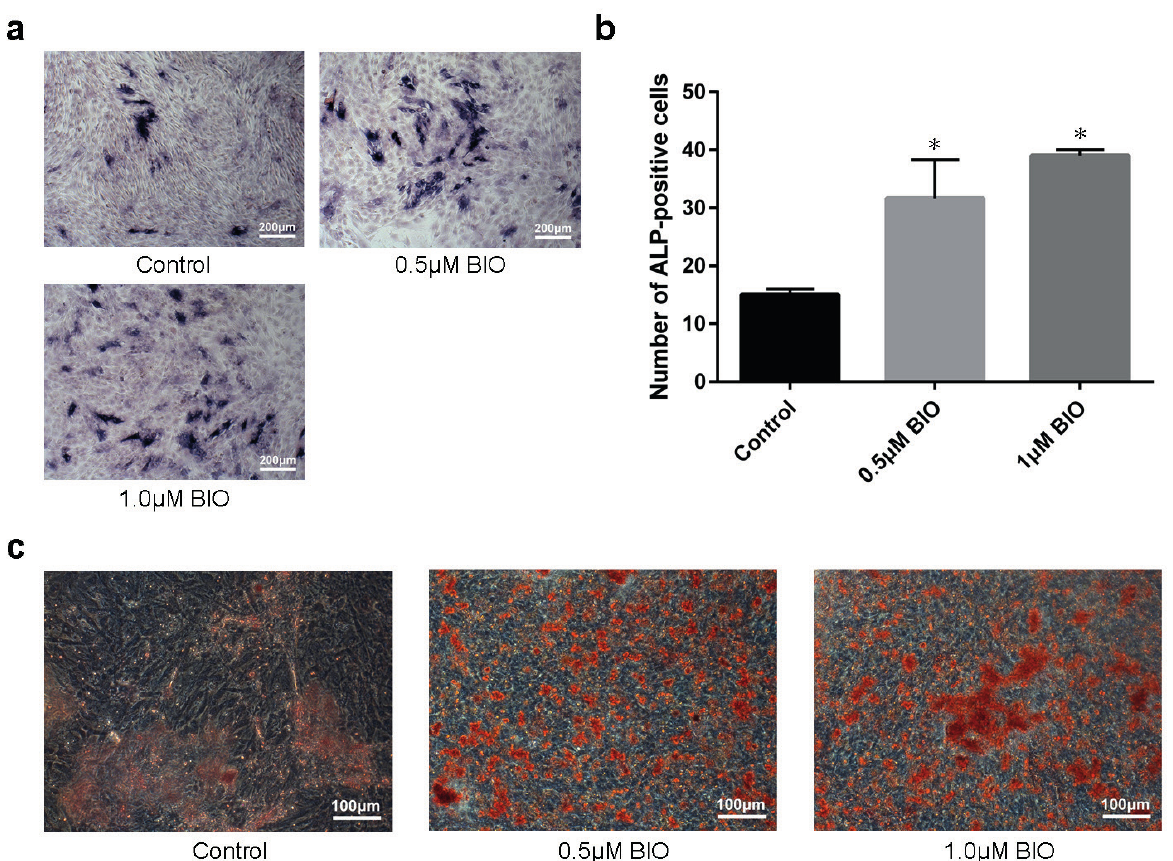
Figure 3 - BIO increased canine BMSCs differentiation towards osteoblasts. ( a ) BIO enhances the number of AlP staining-positive cells and AlP activity. ( b ) Number of AlP-positive cells. Canine BMSCs were incubated with osteogenic medium with or without BIO for 5 days, and fixed for ALP staining or quantitative assay of ALP activity by using p-Npp as a substrate. (n = 3). Error bars denote mean ± SD. *P < 0.05. ( c ) BIO enhanced bone mineralization in canine BMSCs. Canine BMSCs were incubated with osteogenic medium followed by addition of 0, 0.5 and 1.0 μM BIO for 14 d and fixed for alizarin red